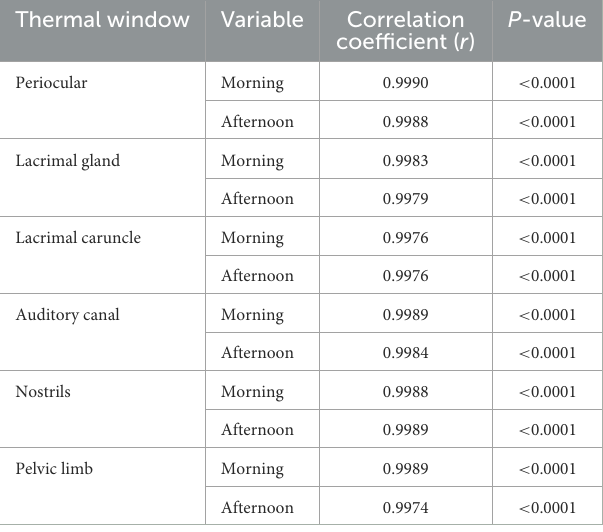
TABLE 8 Significant correlations between the time of day and the surface temperature of the different thermal windows. Thermal